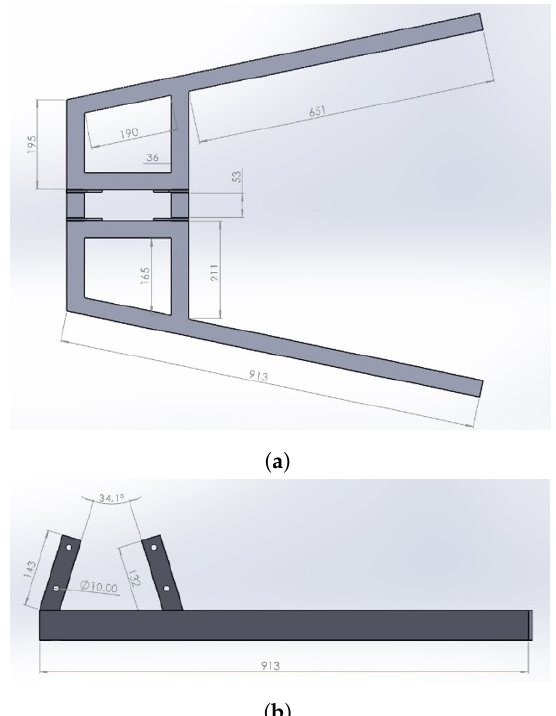
Figure 3. Base frame dimensions; ( a ) top view and ( b ) right view. The base main rod is a link between the base frame and the upper support rod. It has a double joint and mounting to incorporate a weighing scale and hydraulic actuator. A hydraulic actuator is used to lift the patient for weight measuring or lateral turning as needed, as shown in Figure 4.